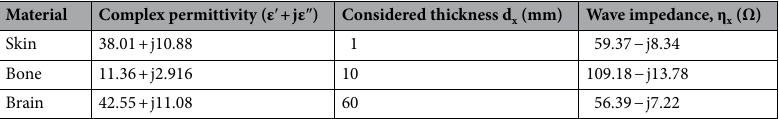
Table 1. Human tissue characteristics at 2.45 GHz 18